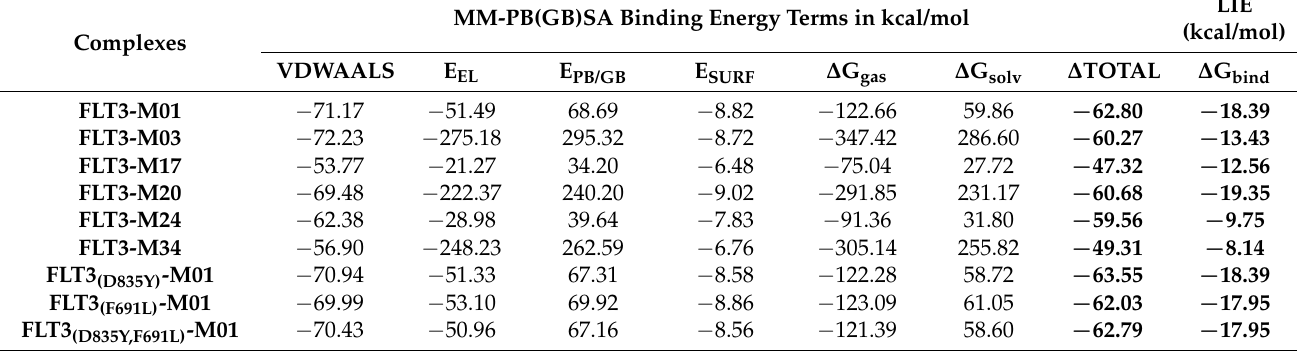
Table 1. MM-PB(GB)SA and LIE energy estimation of the FLT3 inhibitor complexes.